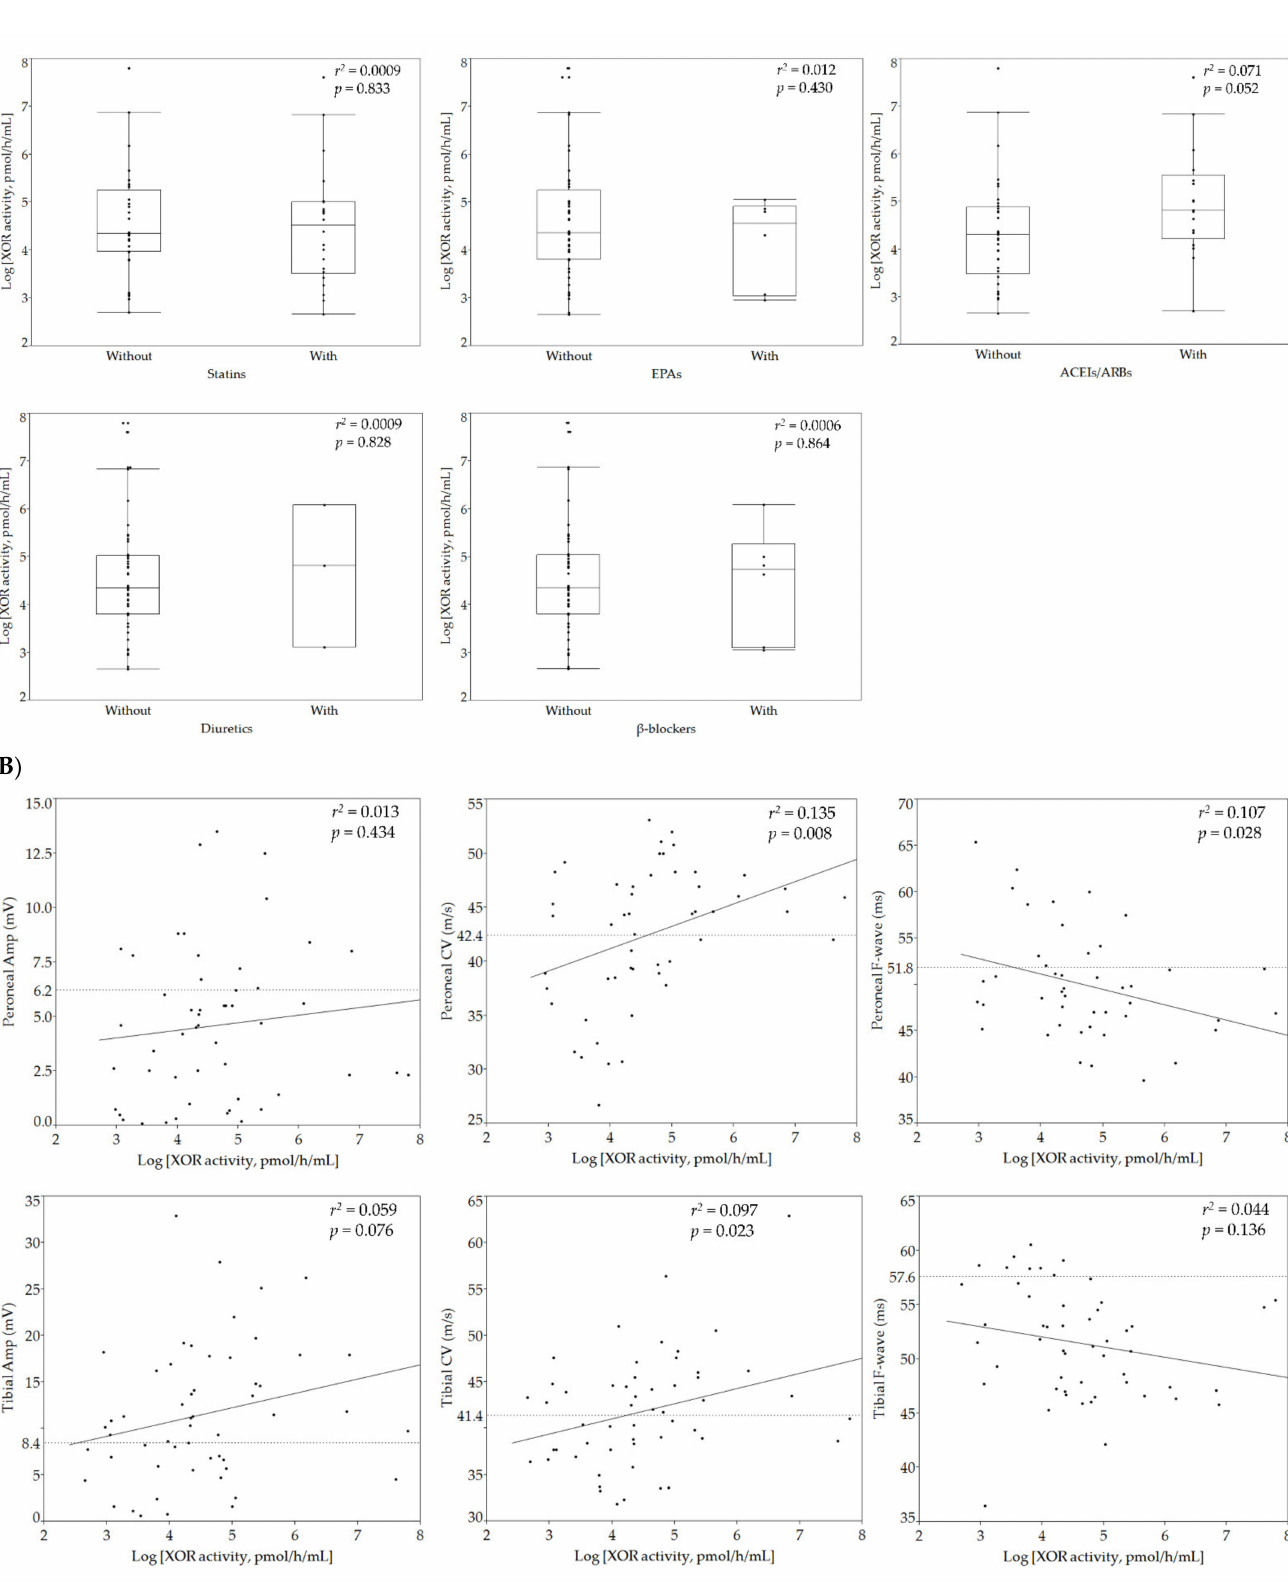
Figure 2. Correlations of individual parameters with logarithmically transformed plasma XOR activity. Results of sex, hypoxanthine, xanthine, UA, age, BMI, waist circumference, VFA, height, SBP, DBP, duration of diabetes, Brinkman index, vibration, minimum ABI, maximum IMT, FBG, HbA1c, Cre, eGFR, ACR, Plt, AST, ALT, γ GTP, AAR, APRI, FIB-4 index, Alb, HDL cholesterol, LDL cholesterol, TG, EPA/AA, CRP, BNP, anti-diabetic drugs, antihyperlipidemic agents, and antihypertensive agents are shown in ( A ), those of various NCS parameters in ( B ). Solid lines indicate regression lines, while each dotted line shows the threshold level of each of the NCS parameters in panel ( B ). The thresholds for peroneal/tibial amplitude potential, peroneal/tibial conduction velocity, and peroneal/tibial F-wave for prediction of incident DSP were 6.2/8.4 mV, 42.4/41.4 m/s, and 51.8/57.6 ms, respectively. SBP, systolic blood pressure; DBP, diastolic blood pressure; Cre, serum creatinine; eGFR, estimated glomerular filtration rate; ACR, albumin to creatinine ratio; Plt, platelet count; FIB-4 index, fibrosis-4 index; EPA/AA, eicosapentaenoic acid to arachidonic acid ratio; BNP, B-type natriuretic peptide; CRP, C-reactive protein; α GIs, α -glucosidase inhibitors; GLP-1RAs/DPP4is, GLP-1 agonists/dipeptidyl peptidase-4 inhibitors; SGLT2, sodium-glucose co-transporter 2 inhibitors; ACEIs, angiotensin-converting enzyme inhibitors; ARBs, angiotensin receptor blockers; CCBs, calcium channel blockers; Amp, amplitude potential; CV, conduction velocity; F-wave, F-wave latency. r2: coefficient of determination, vibration: perception time for a fork